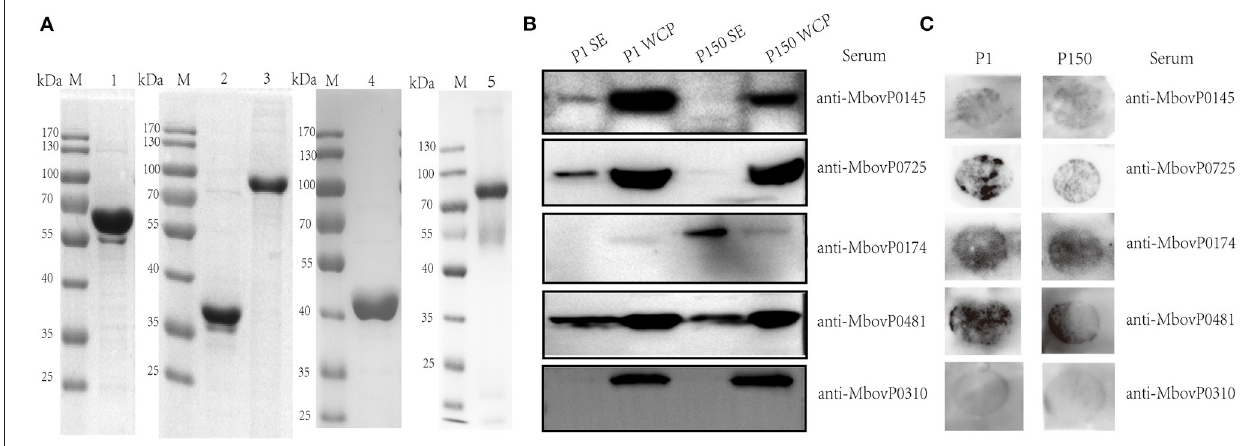
FIGURE 5 | Verification of the secreted nature of five Mycoplasma bovis proteins. (A) Five proteins were expressed, purified, and confirmed by 12% SDS-PAGE. Lane 1: rMbovP0145, lane 2: rMbovP0725, lane 3: rMbovP0174, lane 4: rMbovP0481, and lane 5: rMbovP0310. M represents the protein marker. (B) Western blot verification of the secreted nature of the selected proteins in the M. bovis P1 (virulent) and P150 (attenuated) strains. SE represents the secretomes, while WCP represents the whole cell proteins extracted from the M. bovis P1 and P150 strains. (C) Colony immunoblotting assay to detect the presence of the four selected proteins on the mycoplasma surface. The colonies were incubated with antisera to each protein.